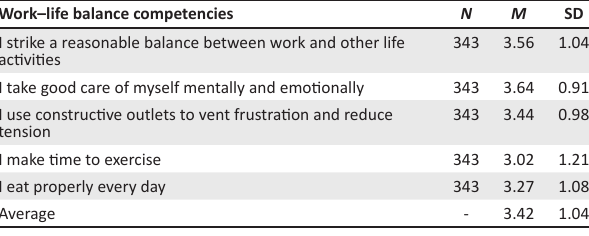
TABLE 4: Work–life balance competencies.